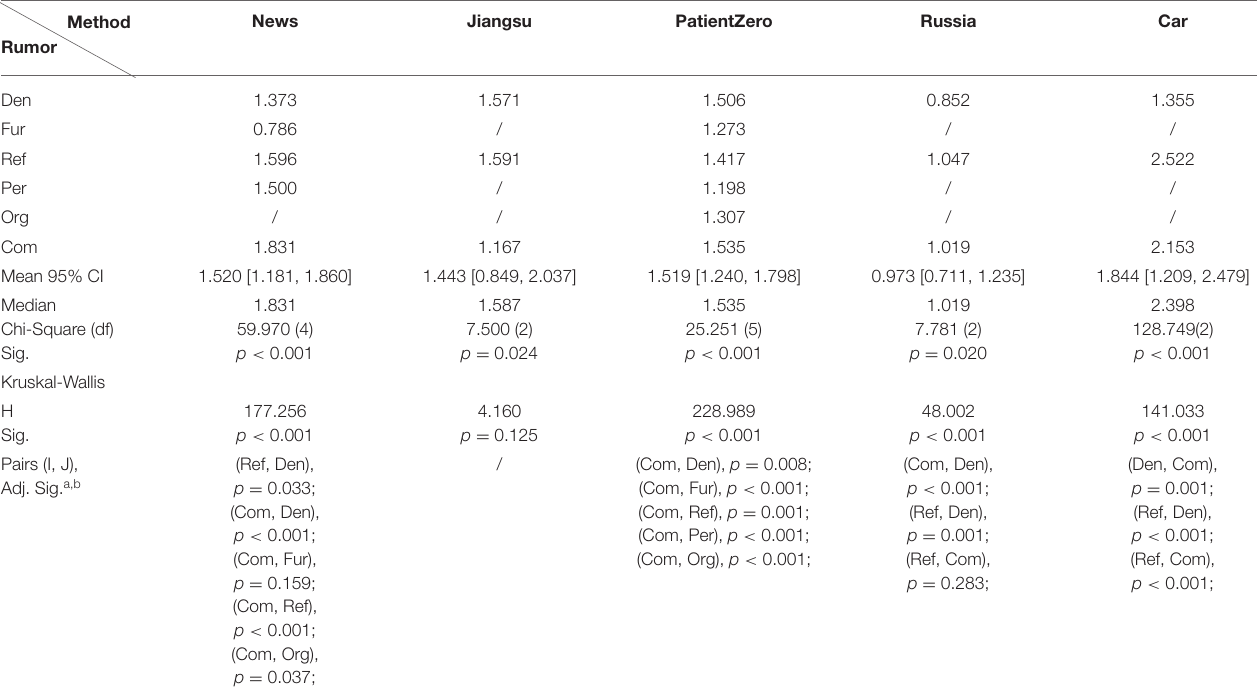
TABLE 6 | Comparison of DEI among five